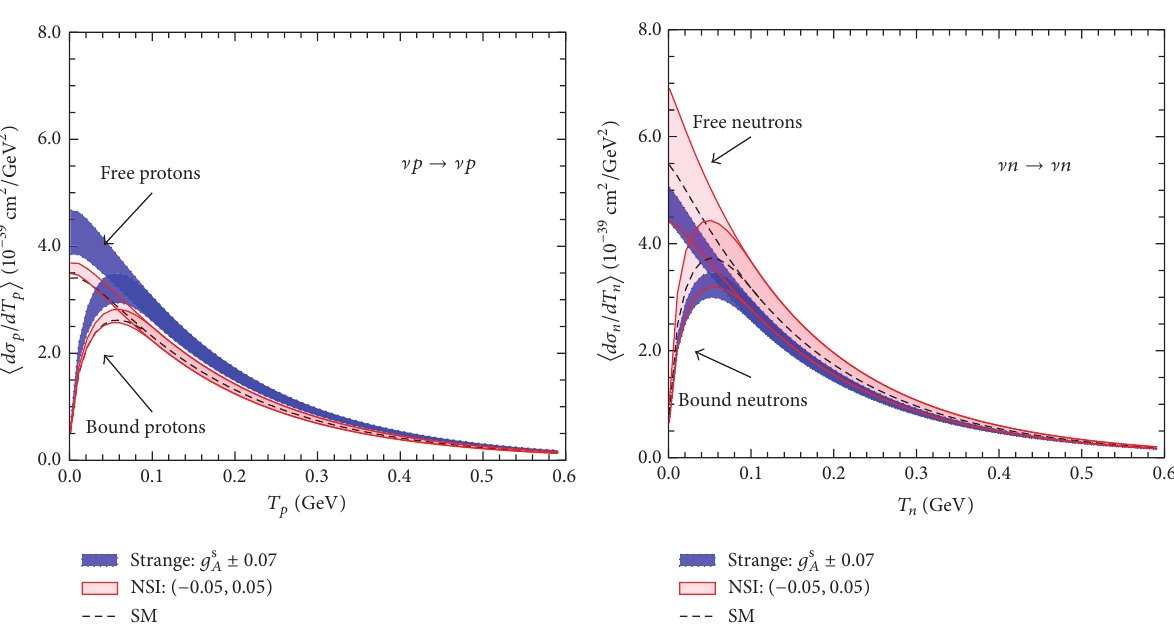
Figure 7: Differential cross section as a function of the nucleon (proton or neutron) recoil energy due to SM, strange quark, and NSI. Modifications due to the employed nuclear effects are illustrated and compared with the case of scattering on free nucleons.